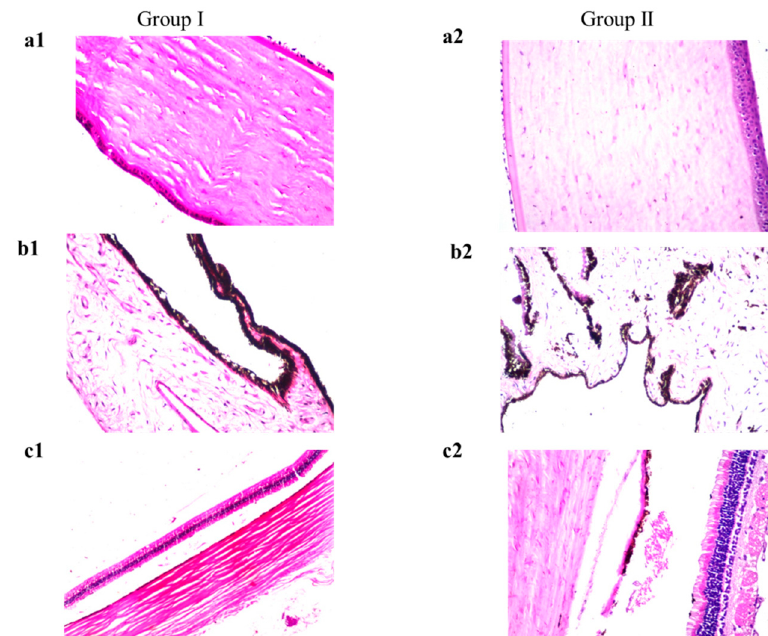
Figure 10. Histopathological photomicrographs (stained with hematoxylin and eosin) showing control rabbit eye (group I) and MS6-treated eye (group II); ( a1 , a2 ) show the cornea, ( b1 , b2 ) show the iris, ( c1 , c2 ) demonstrate the retina, choroid and sclera with normal histological structure ( × 40 magnification power). Photomicrographs of Group I (( a1 , b1,c1 )) were adopted from Aziz et al. [14].